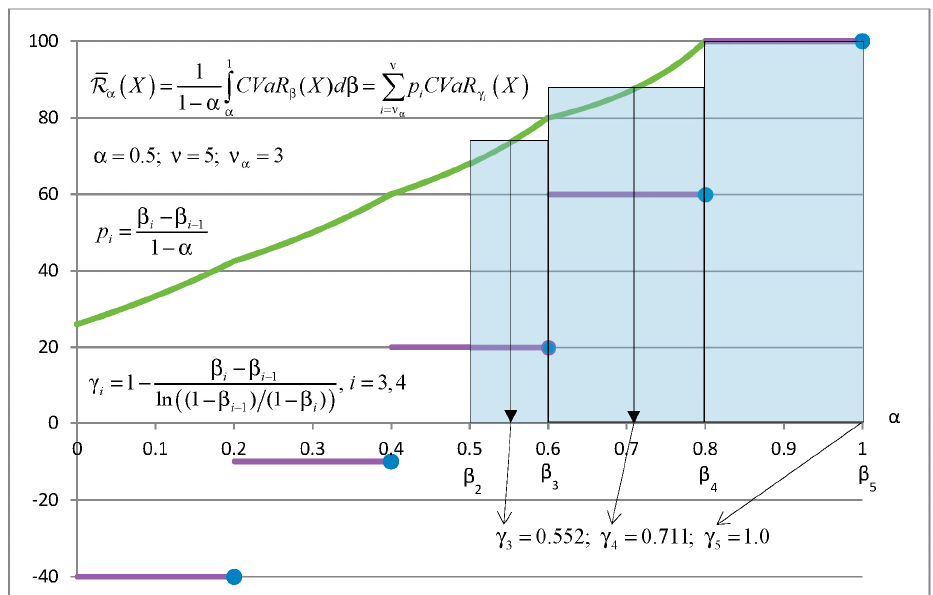
Figure 2. Five equally probable atoms. Risk in the CVaR quadrangle and mixed-quantile quadrangle with Set 1 of parameters for 𝛼 = 0.5.